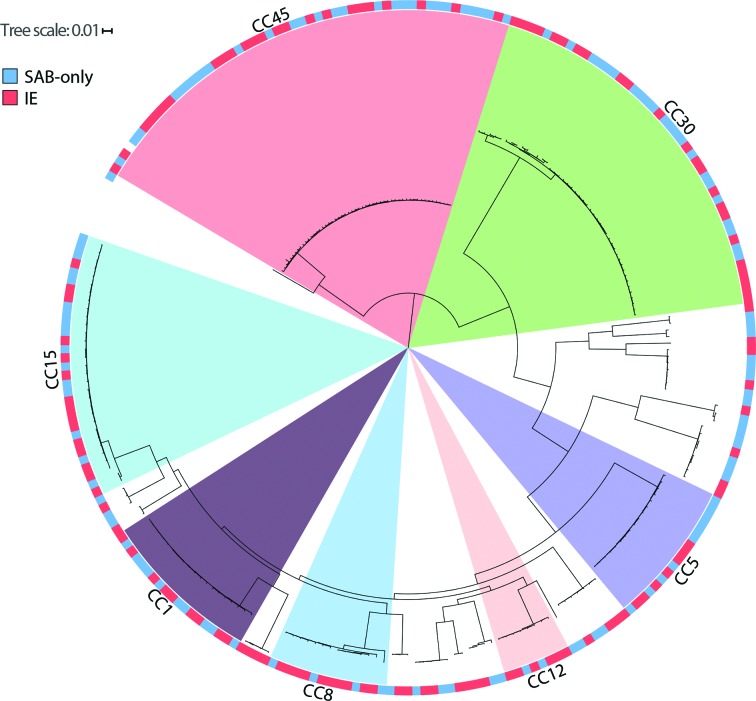
Rooted phylogenetic analysis using a maximum likelihood approximation on the 120 850 SNPs identified in the conserved core genome of the 241 S. aureus isolates. The tree is rooted on the CC45 branch [49] and CC groups with more than 10 isolates are highlighted. Outer circle corresponds to infection type (red=IE, blue=SAB-only). For identification of specific samples see Fig. S5.